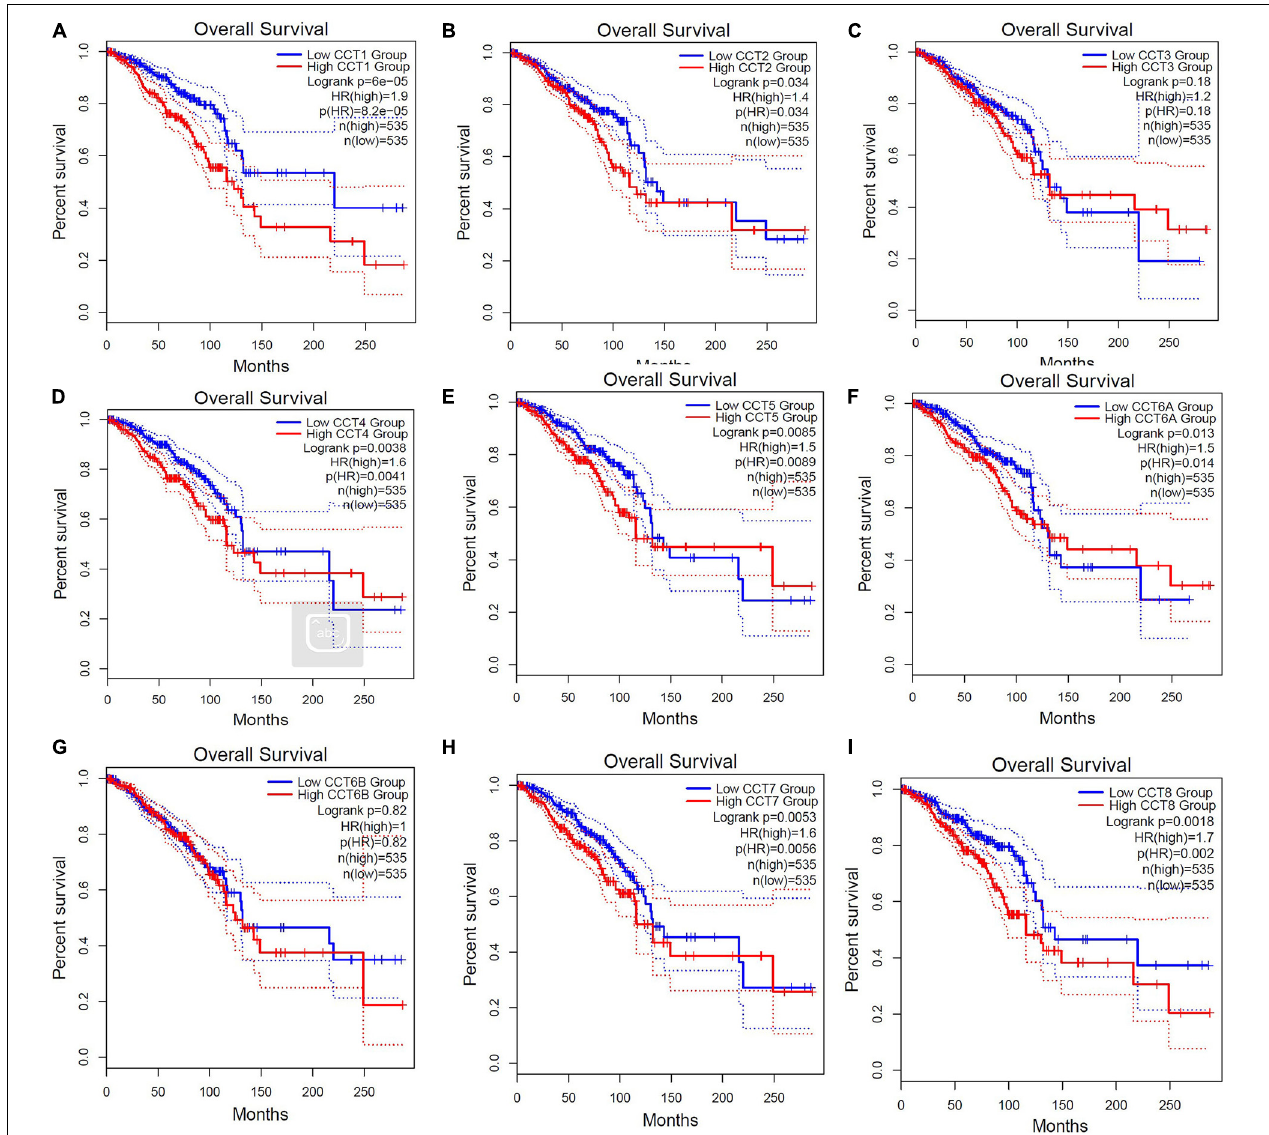
FIGURE 4 | Elevated expressions of eight subunits of the chaperonin TRiC were associated with poor clinical outcomes (OS). Prognostic value of mRNA level of TRiC in BCa patients (A) TCP1, (B) CCT2, (C) CCT3, (D) CCT4, (E) CCT5, (F) CCT6A, (G) CCT6B, (H) CCT7, and (I)